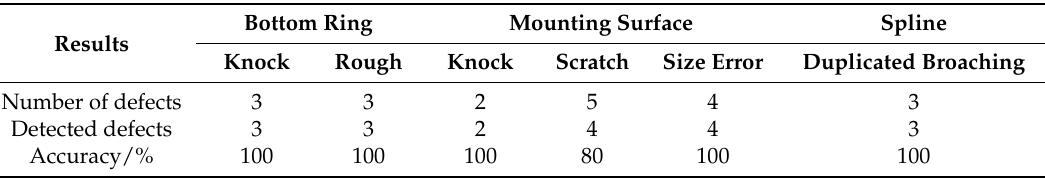
Table 7. Bottom surface inspection of gear F 6